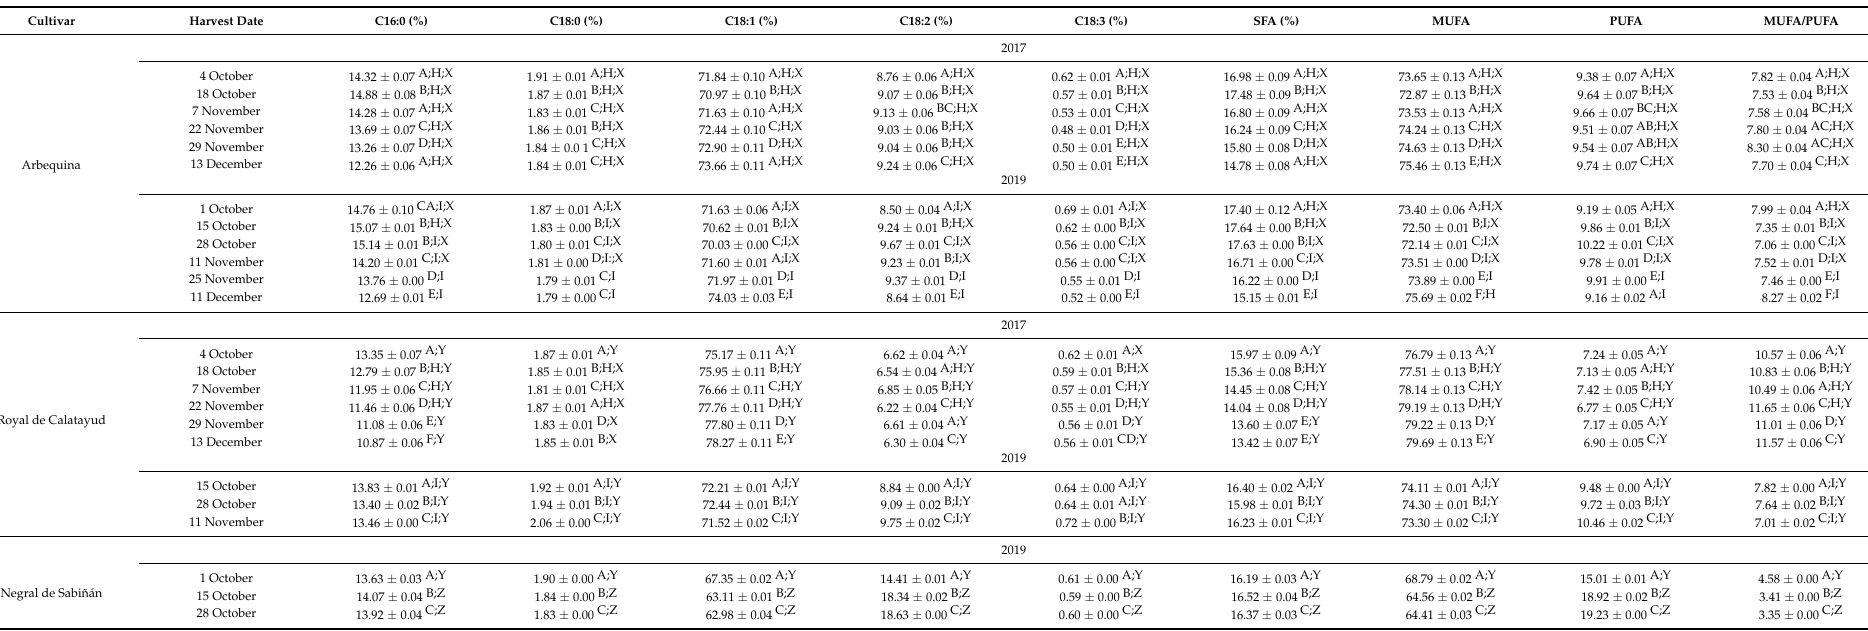
Table 2. Evolution of fatty acid composition and indices according to harvest date for the “Arbequina”, “Royal de Calatayud” and “Negral de Sabiñ á n” olive oils in the 2017 and 2019 crop